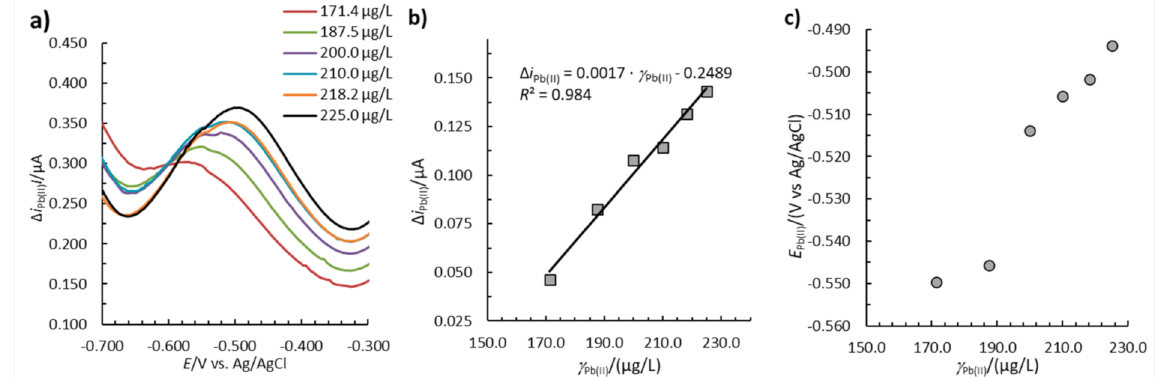
Figure 1. ( a ) Voltammograms measured for the unmodified SPE at different γ Pb(II) for a single drop placed on the SPE holder, ( b ) the linear concentration range, and ( c ) the change in E Pb(II) vs. γ Pb(II) . The measurements were performed at E acc = − 1.5 V and t acc = 60 s in 0.1 M acetate buffer (without Bi(III)).